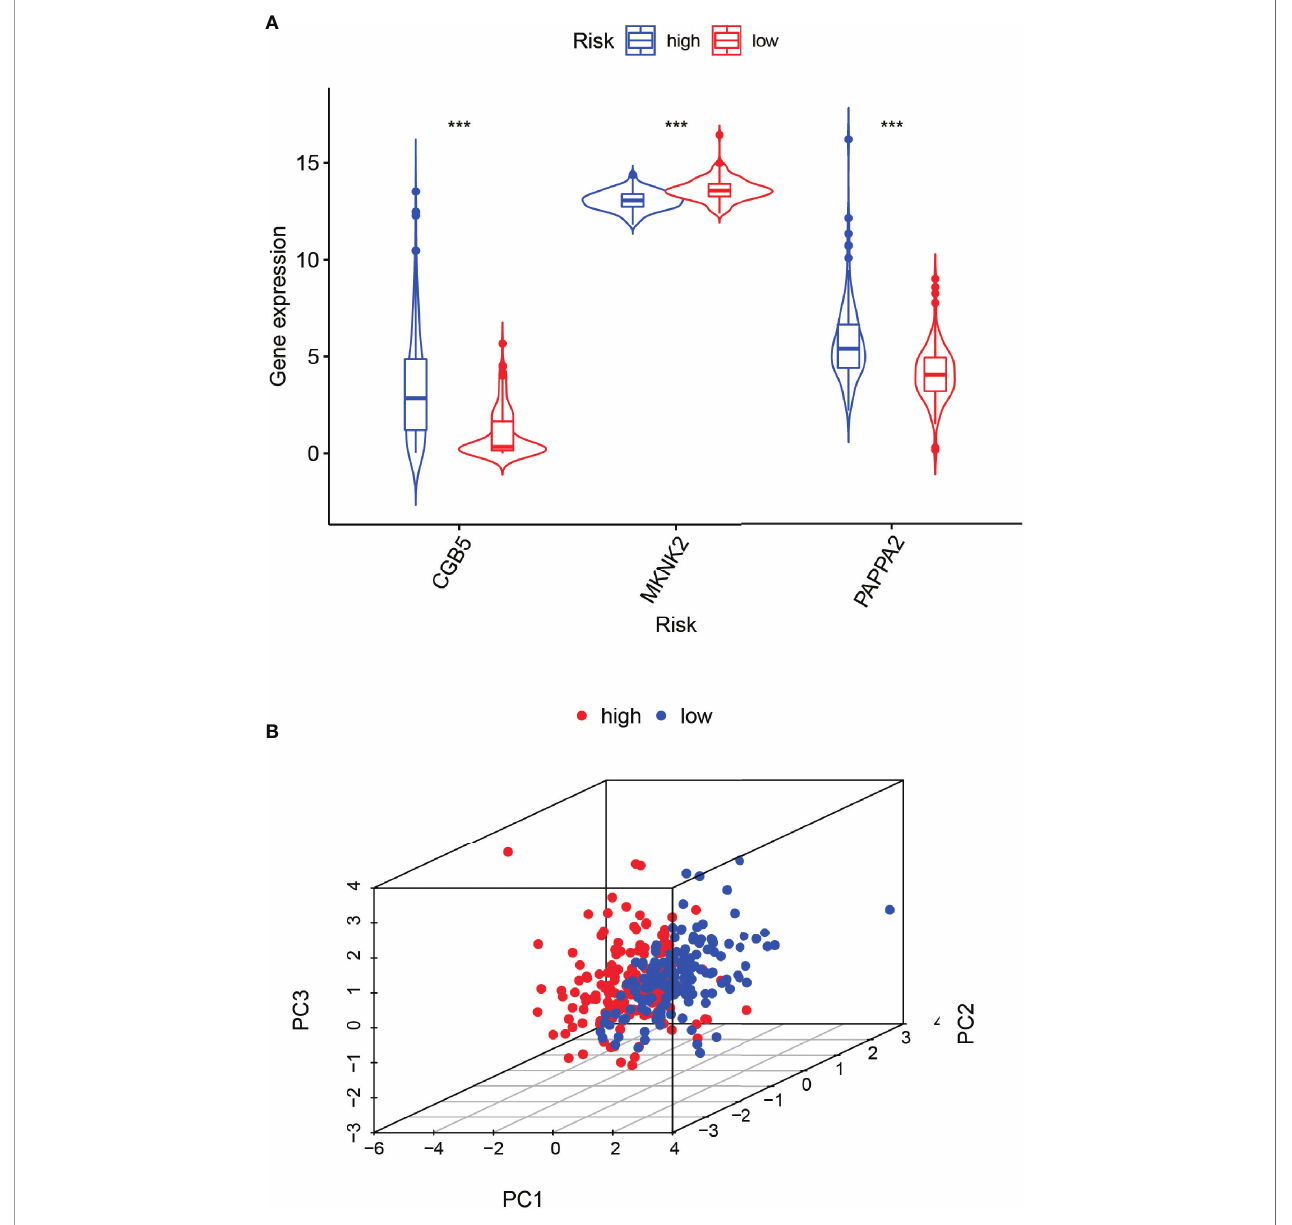
FIGURE 7 | Expression differences between high and low risk groups and principal component analysis. The (A) -plot represents the difference in gene expression values of the three genes based on the high and low risk of the constructed model. The (B) -plot represents the principal component analysis based on high and low risk, high risk group and low risk group. ***P <